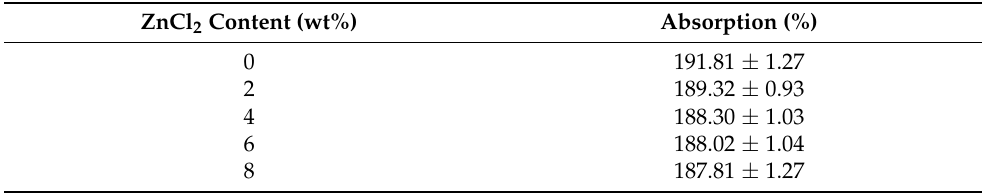
Table 1. Percentage absorption of EVA/CWF composites at different ZnCl 2 contents.